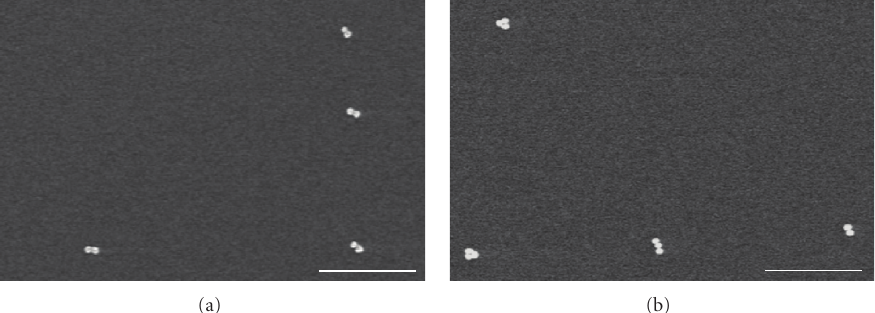
Figure 3: SEM images of dimer (a) and trimer (b) samples deposited on silicon substrates (30keV electrons, scale bar = 500 nm).